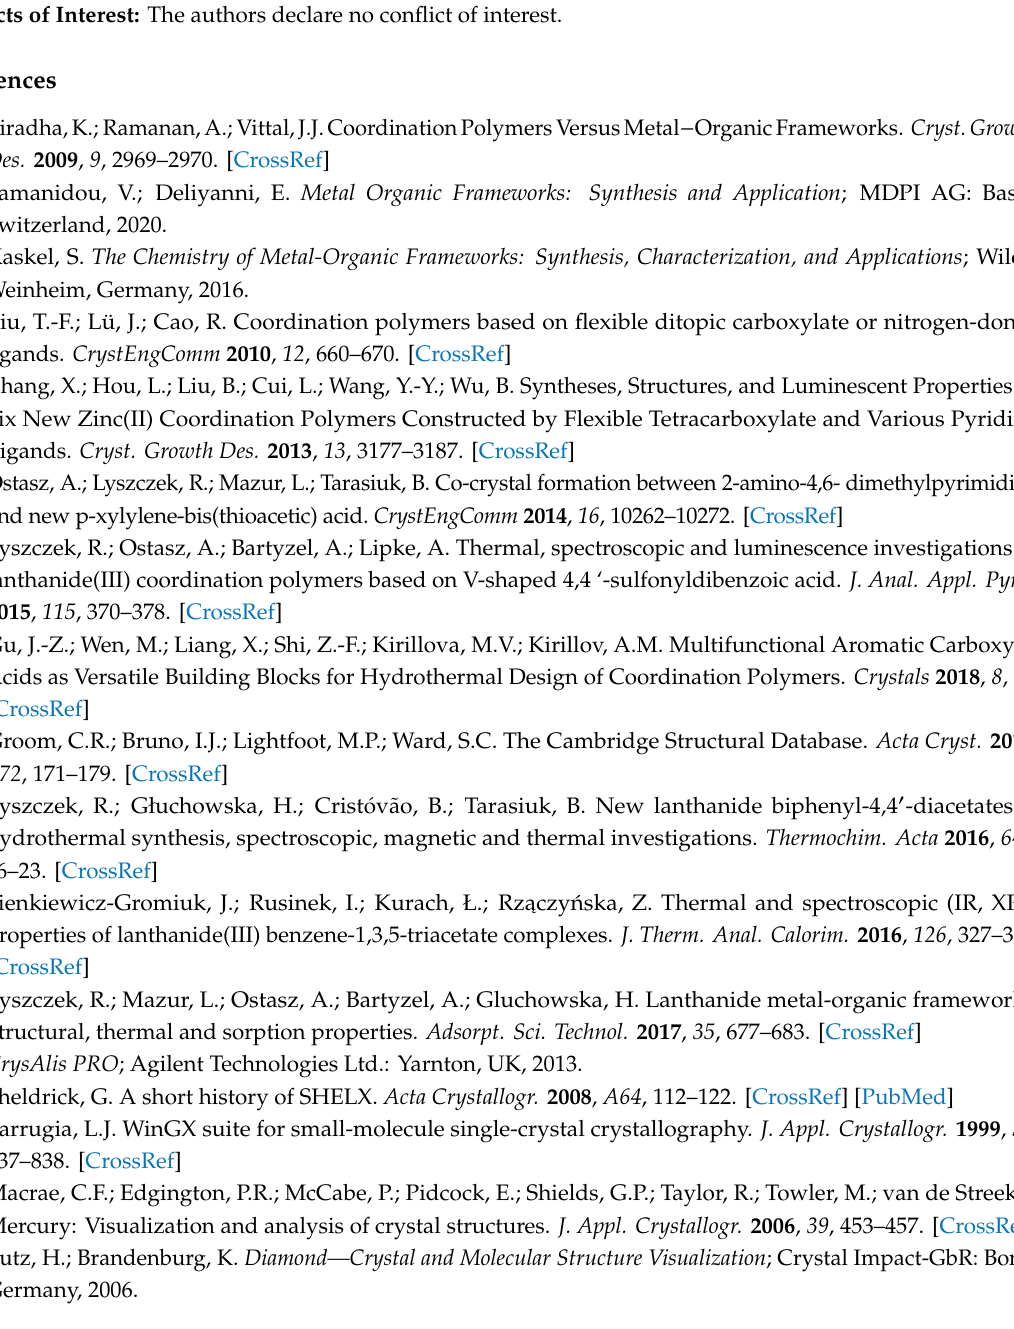
Figure S1: PXRD pattern of 1H after decomposition, Figure S2: Additional crystal packing patterns of 1H , Figures S3 and S4: FTIR spectra of gaseous products formed during the decomposition of 1P , Figure S5: DSC plots of 1P and 1H , Table S1: Selected structural parameters for 1H and 2H